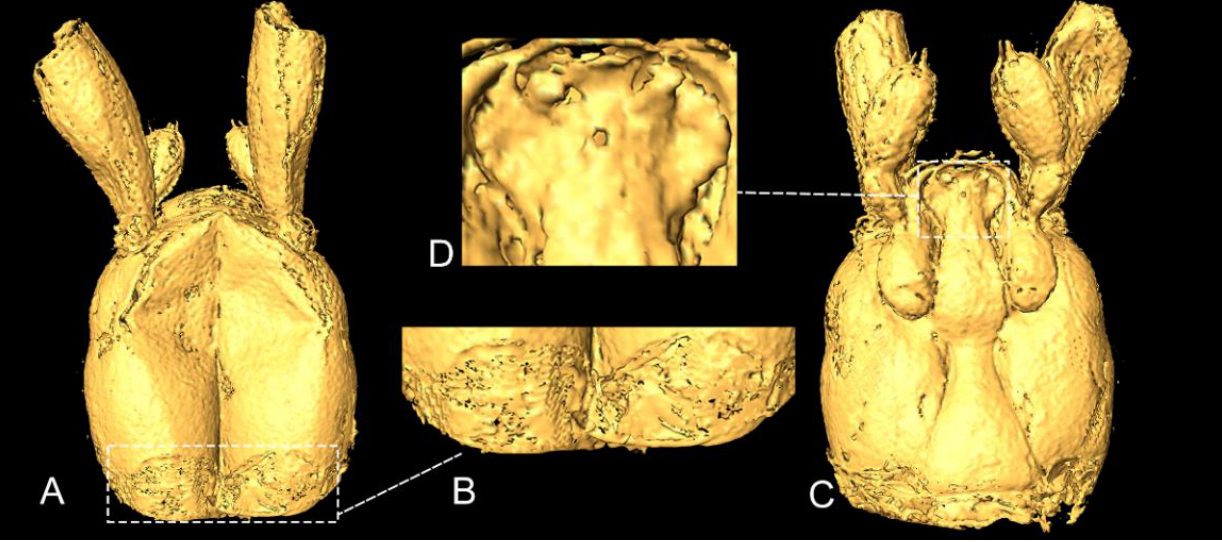
Figure 2. Pareburniola dominicana gen. et sp. nov. Head, dorsal ( A ); details of glandular region ( B ); ventral ( C ); prementum ( D ); habitus, dorsal ( E ); segment IX ( F ); ventral ( G ); metasternum ( H ).